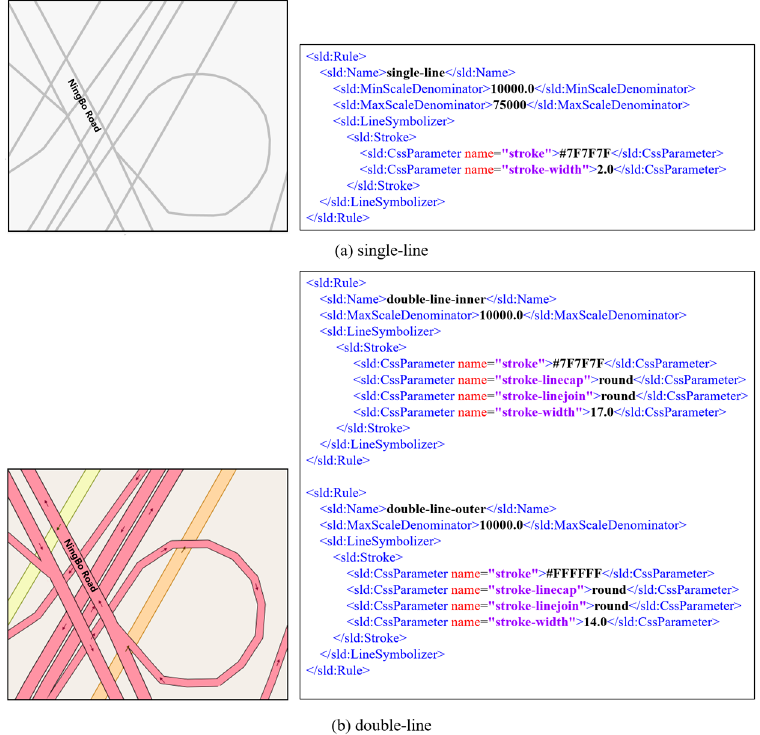
Figure 1. Linear map symbols representing road networks.